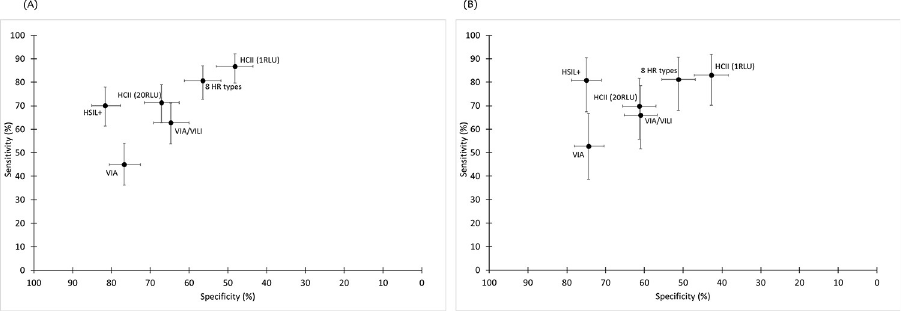
Fig 3. Sensitivity and specificity of screening strategies for prevalent CIN2+ and CIN3+ in South Africa. (A) CIN2 +; (B) CIN3+. CIN, cervical intraepithelial neoplasia; HCII, Hybrid Capture 2; HR, high risk; HSIL+, high-grade squamous intraepithelial lesion or greater; RLU, relative light unit; VIA, visual inspection using acetic acid; VILI, visual inspection using Lugol’s